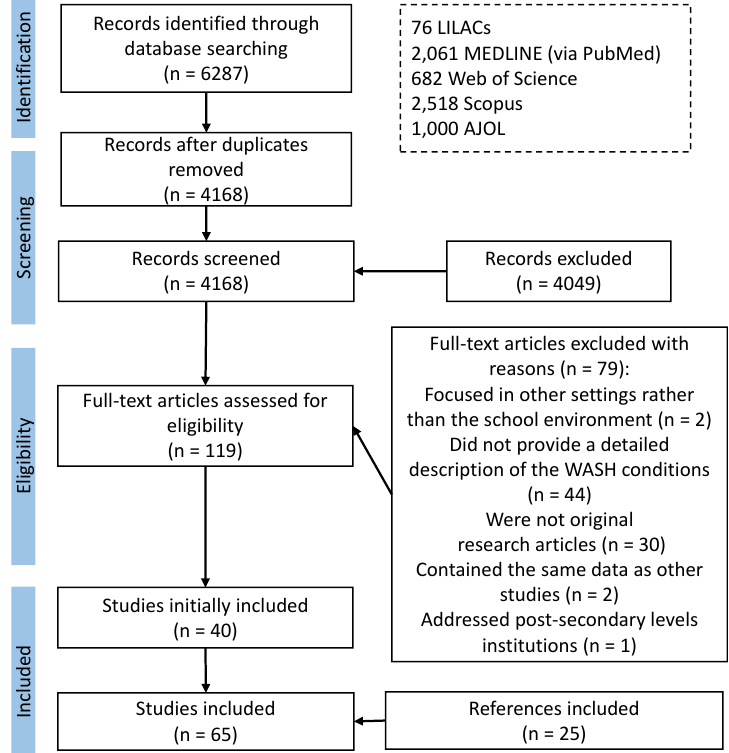
Figure 1. PRISMA flow diagram for the systematic literature review on water, sanitation and hygiene in schools in low- and middle-income countries.